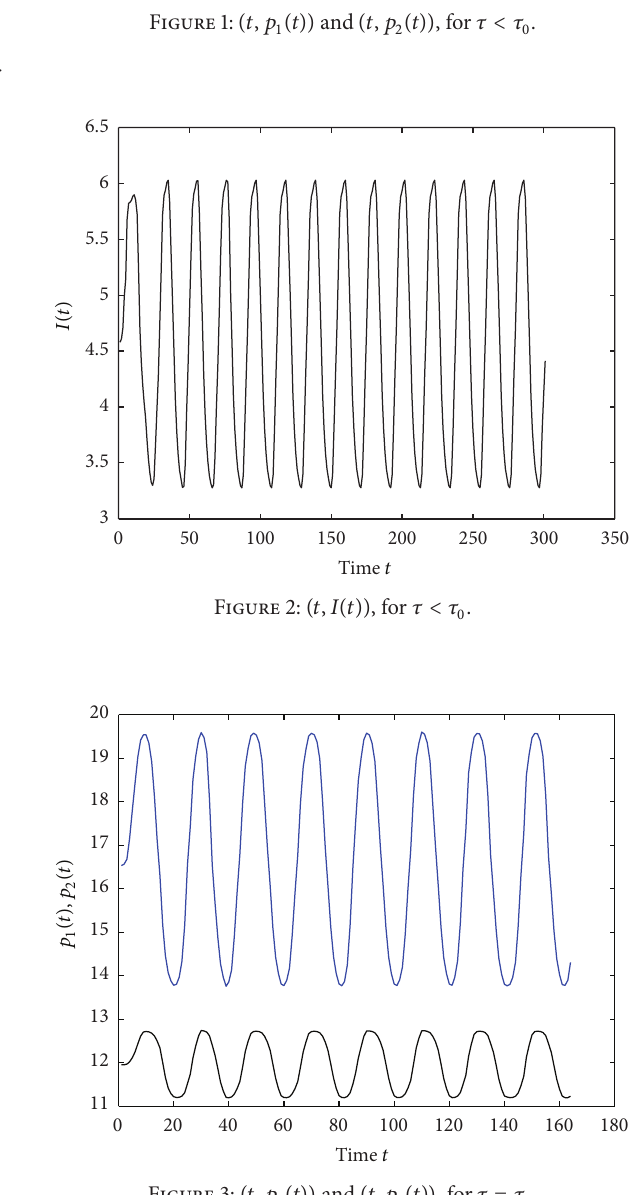
Figure 3: (𝑡,𝑝 1 (𝑡)) and (𝑡,𝑝 2 (𝑡)) , for 𝜏 = 𝜏 0